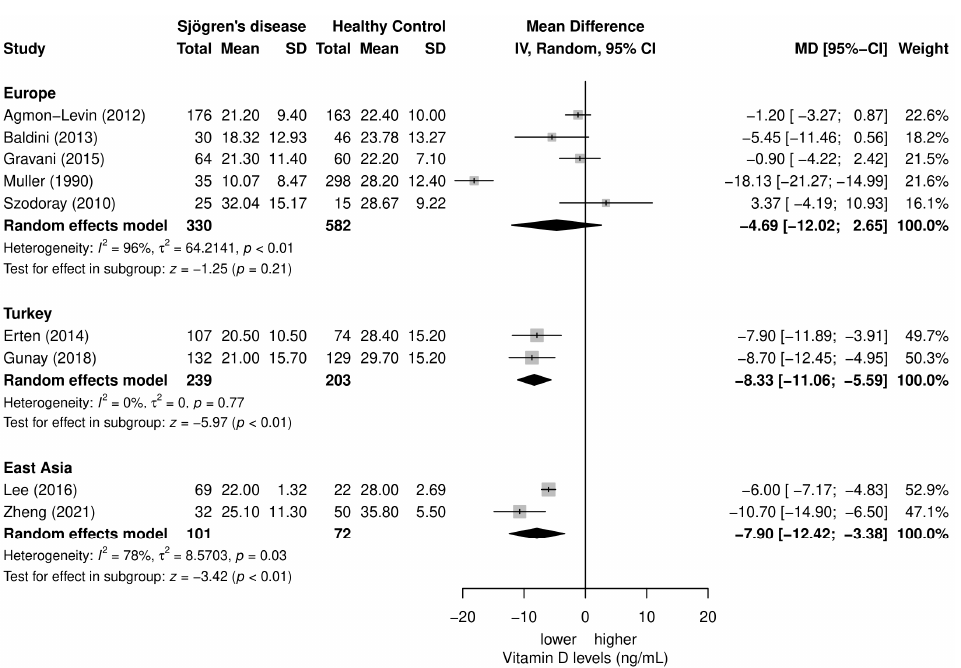
Figure 4. Subgroups meta-analysis based on geographical location of included studies evaluating the vitamin D levels in SD patients in comparison to controls [18–26].